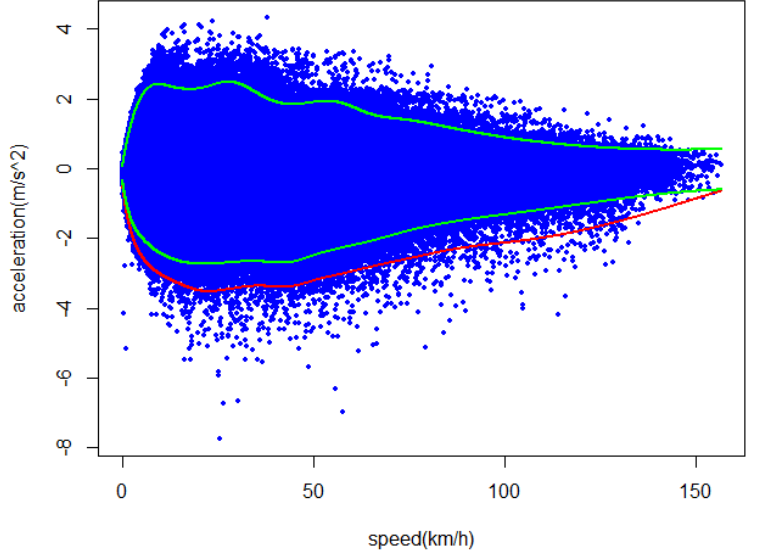
Figure 4. Joint-distribution of